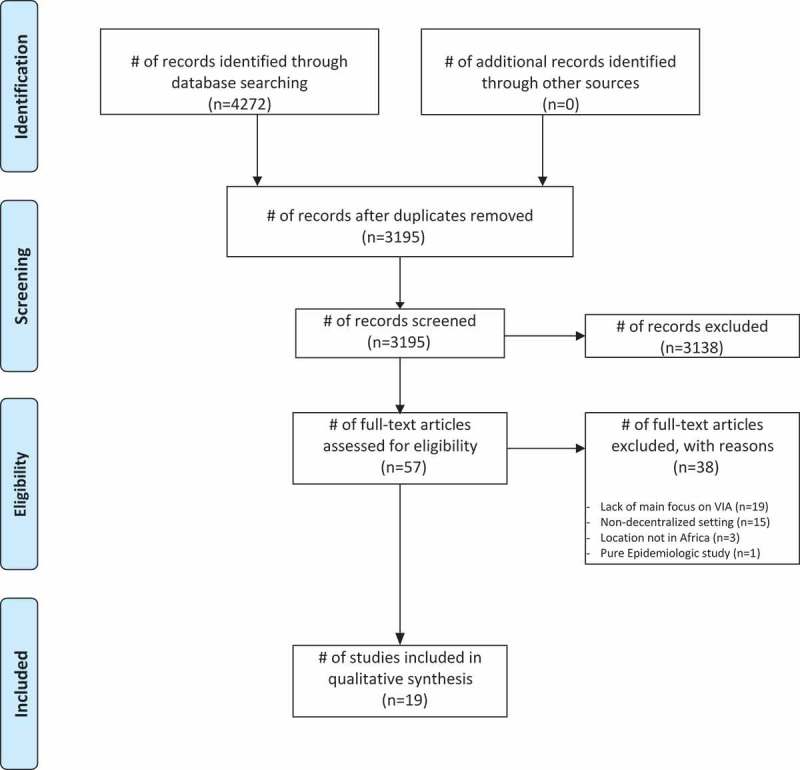
PRISMA flow diagram.